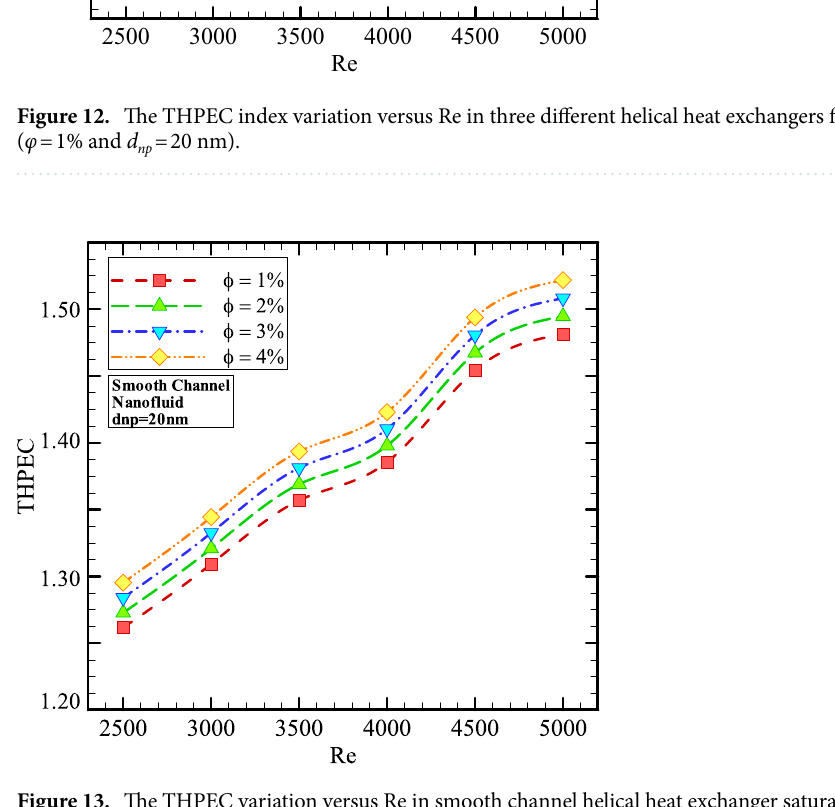
Figure 13. The THPEC variation versus Re in smooth channel helical heat exchanger saturated with nanofluid ( d np = 20 nm) in different volume